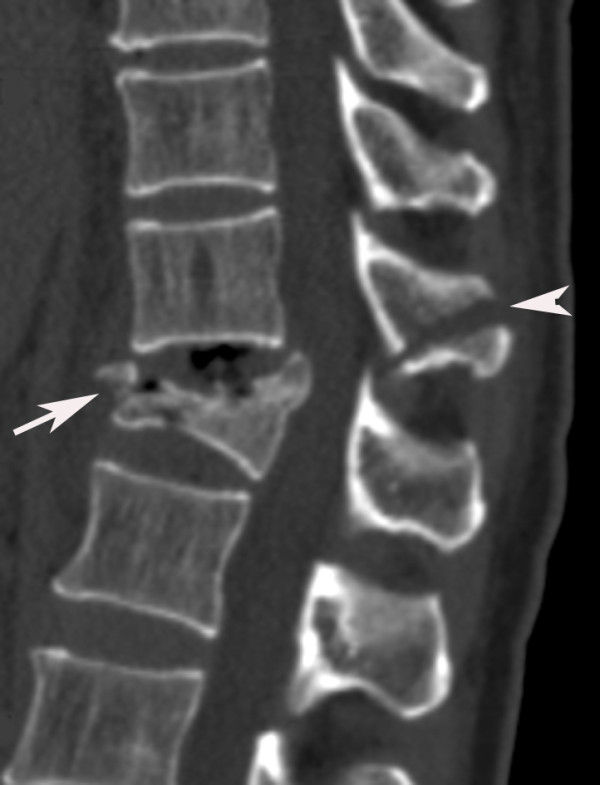
Reformatted sagittal image clearly shows spinous process distraction of T11 (arrowhead) and associated burst fracture (type A3) of T12 (arrow). Thus this is a Magerl (AO: Arbeitsgemeinschaft fur Osteosynthesefragen classification) type B2 lesion (posterior disruptions that predominantly involved osseous).